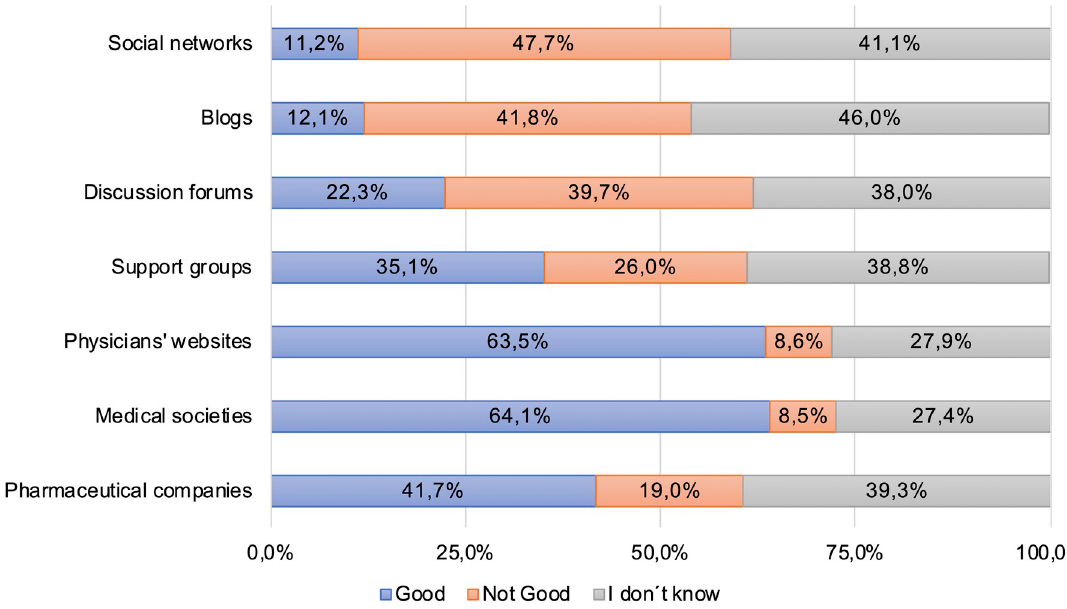
Fig 4. Patients’ assessment of the quality of online sources for health-related